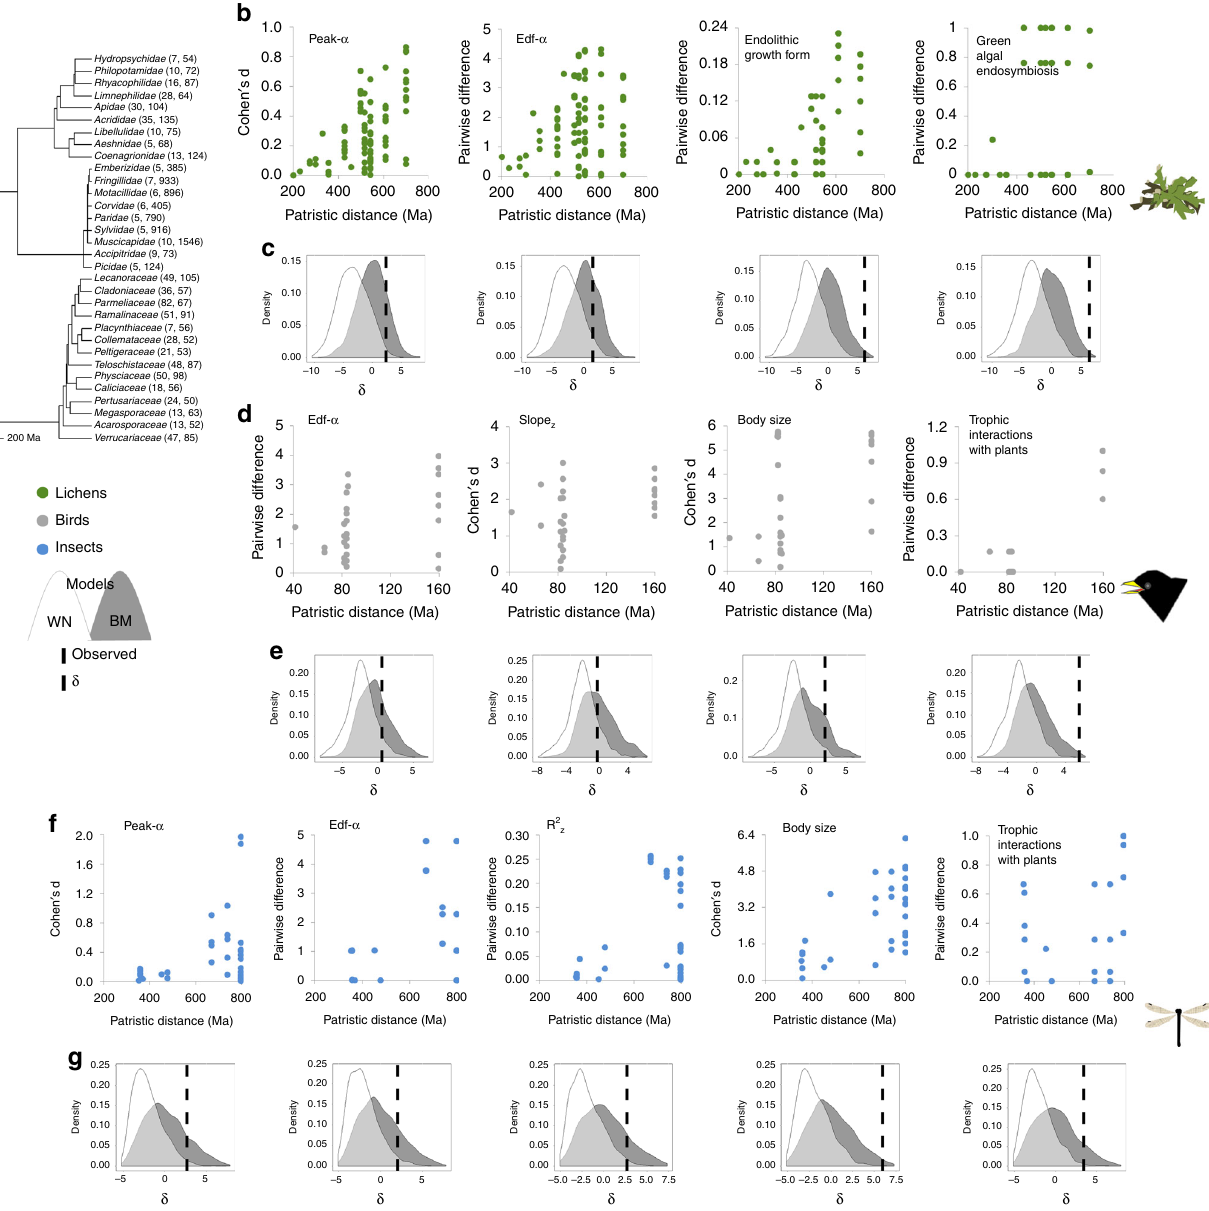
Fig. 2 Signi fi cant phylogenetic patterns in diversity responses and organismal traits. a Time-calibrated phylogenetic tree of families, with the number of species and sampling plots in parentheses (the three major taxa are represented in a single tree for representative purposes only). b , d , f Scatterplots representing how dissimilarities in community responses or organismal traits, quanti fi ed as effect sizes or raw differences on the y -axis, increase with evolutionary time, represented by patristic distances in million years (Ma) in the x -axis; each point represents a pairwise comparison between families. c , e , g The density plots below each scatterplot represent, for the same variables as scatterplots, the distribution of the likelihood ratio statistics δ for a two model comparison, a null model with random draws independent of the phylogeny (white noise WN model, lighter density distributions) and a Brownian motion BM model of evolution (darker density distributions). The dashed vertical line indicates the observed value of δ when the models are fi t to our data set. A total of 1000 replicates were used for each distribution. Peak- α : elevation at which species richness peaks. Edf- α effective number of parameters of the smoothing function, Slope z elevational turnover, R 2 z magnitude of elevational turnover. Source data are provided as a Source Data fi